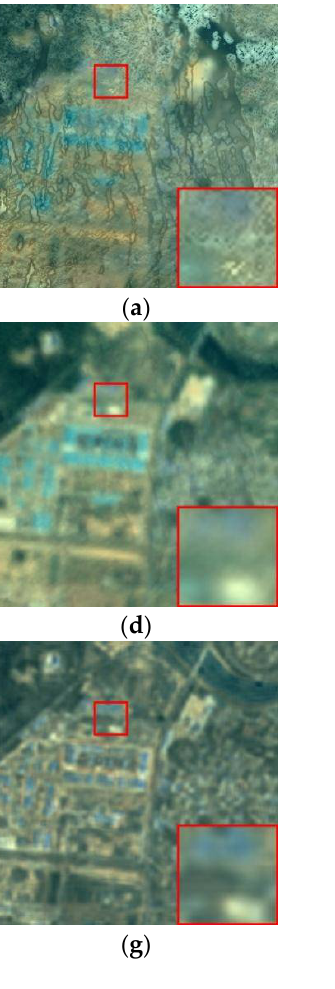
Figure 9. The fused images of GaoFen-1 where ( a ) IHS, ( b ) Wavelet, ( c ) HPF, ( d ) PRACS, ( e ) PNN, ( f ) Fusion-Net, ( g ) SSConv, ( h ) DS-MDNP, and ( i ) GT. Table 5. Quantitative evaluation comparison of fusion results on the GaoFen-1 dataset. The values in bold represent the best result.